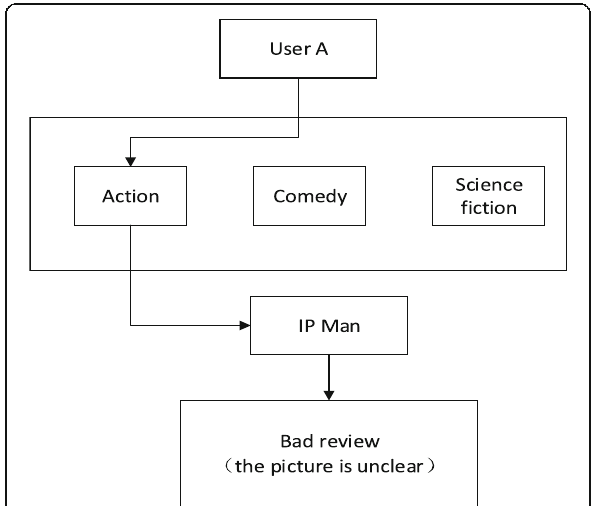
Fig. 1 Example of user behavior. User A loves to watch action movies, but does not love science fiction and comedy movies. User A finds a movie called “ IP MAN ” in the action movie category. After watching it, user A feels that the clarity of the picture is not good, so he gives the film a low score. If user A does not like the action movie, he will not see this category of movies. The traditional collaborative filter considers that as long as the user gives a low score that users do not like this type of film, but the fact is that if the user does not like a film, users will not pay attention to this type, let alone watch and